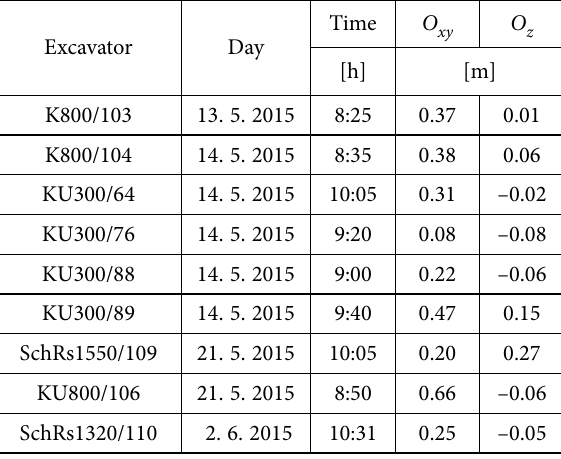
Table 5. Results of control at Nástup Tušimice mine Excavator